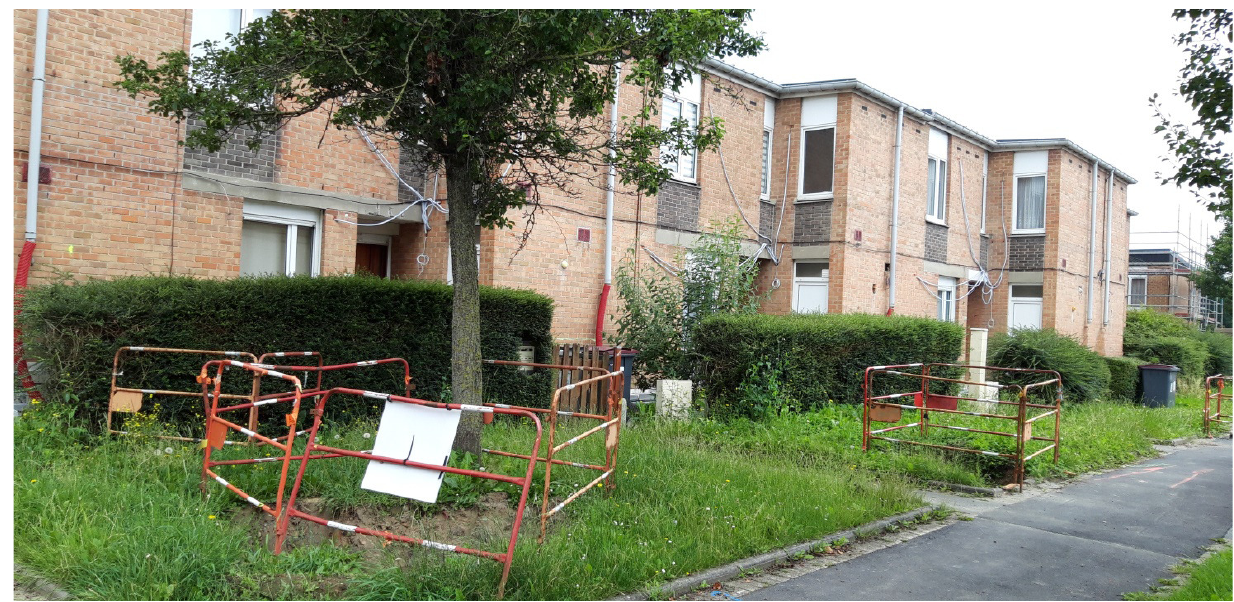
Figure 4. Public space affected by energy network upgrade in